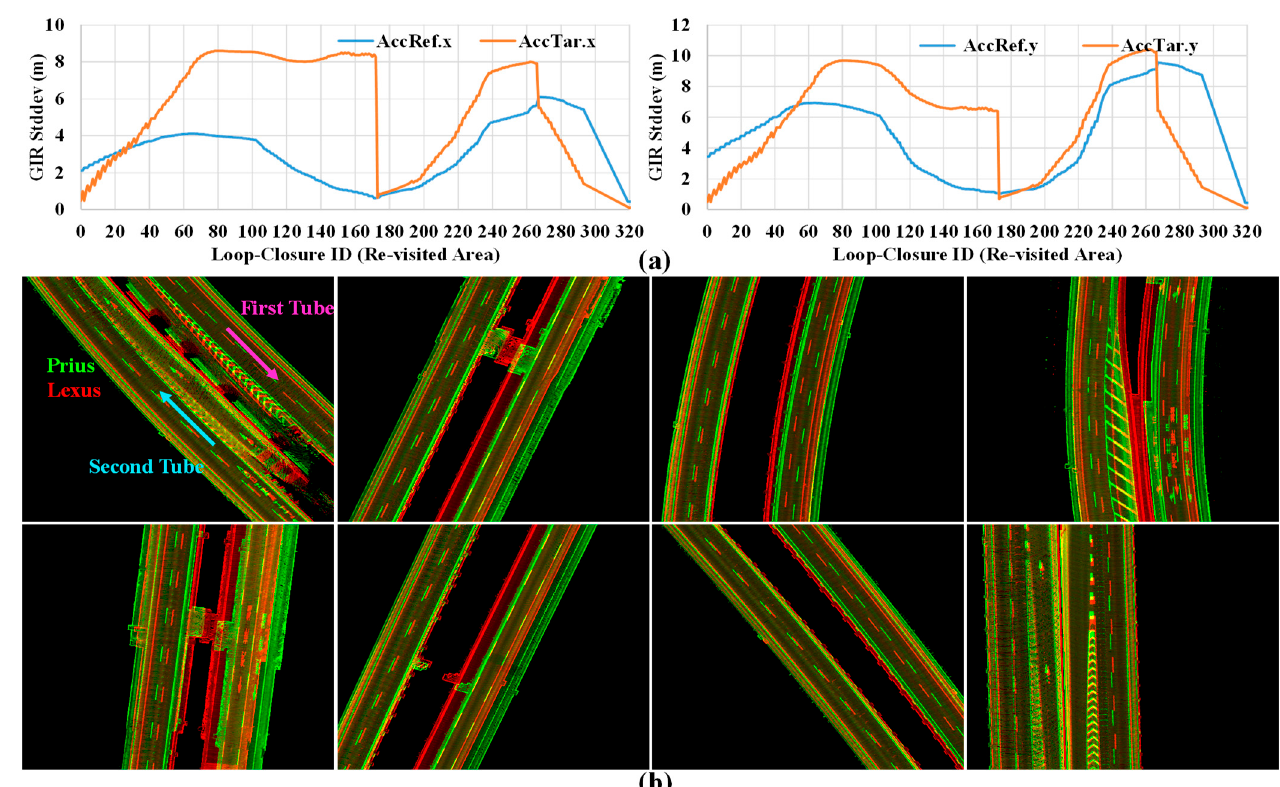
Figure 10. Scanning two tubes of the world’s longest tunnel using two agents with different sensor configurations. ( a ) GIR accuracy of each agent in X and Y directions. ( b ) GIR combined map images showing different deviations in lateral and longitudinal directions along the first and second tubes.